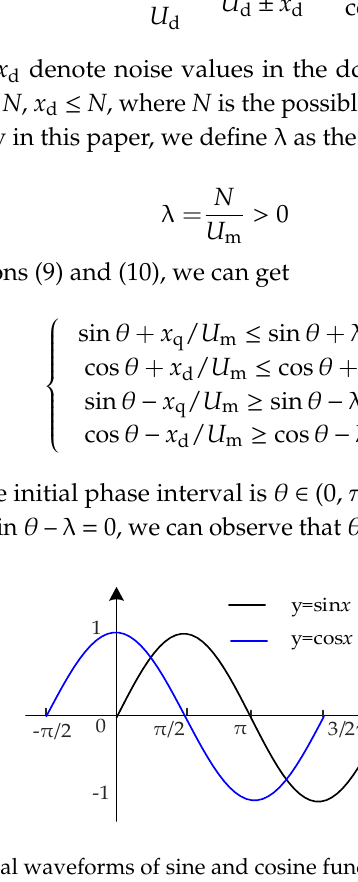
Figure 3. Partial waveforms of sine and cosine functions when θ ∈ (0, π /